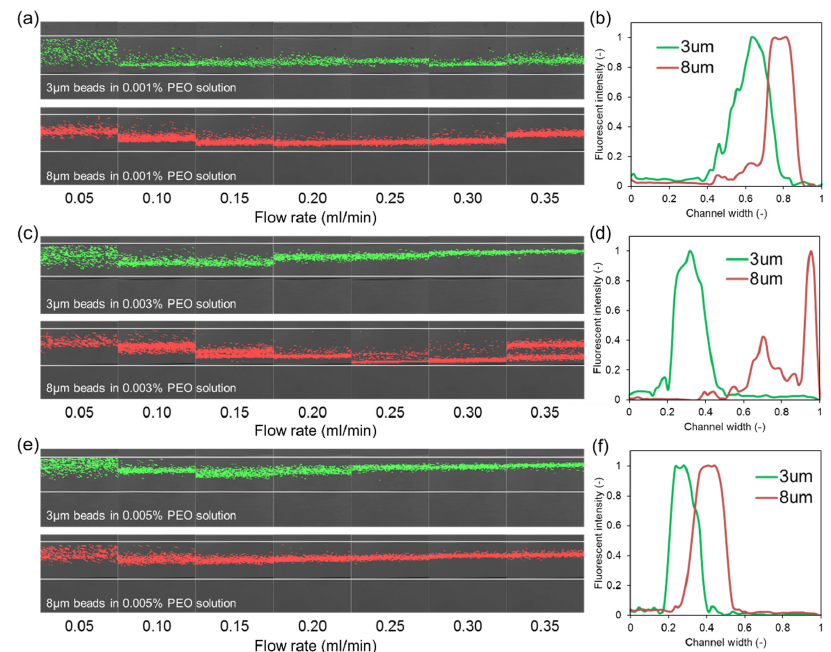
Figure 4. Distribution of 3 µ m beads (green) and 8 µ m beads (red) near the outlet of the spiral channel device. ( a , c , e ) represents particle focusing stream under different flow rates in PEO solutions with concentration of 0.001%, 0.003%, and 0.005%. ( b , d , f ) represent the corresponding particle focusing stream distributions at 0.3 mL/min. When the concentration of PEO measures 0.001%, the viscoelastic focusing force is low, and the inertial focusing force dominates particle movement as shown in Figure 1a. Both the 3 and 8 μ m particles are focused towards the inner side of the channel under all tested flow rates. The diagram of stream distribution indicates that 8 μ m particles have a focusing position closer to the channel inner sidewall due to Dean flow. However, the focused peaks of the two particles are very close to each other with significant overlap. This proximity could inhibit the detection of two different types of particles and renders separation impossible. In comparison, when the concentration of PEO is 0.005%, the viscoelastic force dom ‐ inates particle movement (Figure 1b). Both the 3 and 8 μ m particles are focused towards the outer side of the channel, and the 3 μ m particles have focusing positions closer to the sidewall. The focused bands are tightest at 0.30 mL/min, representing approximately 10% of the channel width for both particle types. As shown in the right column of Figure 4, the focused peaks of the two particles are still very close to each other with significantly over ‐ lapping peaks. Again, this proximity inhibits the detection of two different types of parti ‐ cles and would make complete separation impossible. The focusing stream width in the viscoelastic focusing regime is smaller than that in the inertial focusing regime. It could be explained by the fact that particles have two focusing streams in the vertical direction in inertial focusing, while there is only one focusing stream in the viscoelastic focusing. Between the two concentrations, when the concentration of PEO is 0.003%, particles with different sizes are dominated by different focusing regimes as shown in Figure 1c. The movement of 3 μ m particles is dominated by the viscoelastic focusing. Particles get focused to the channel centerline and pushed to the outer sidewall by Dean flow. The movement of 8 μ m particles is dominated by inertial focusing. Particles become focused